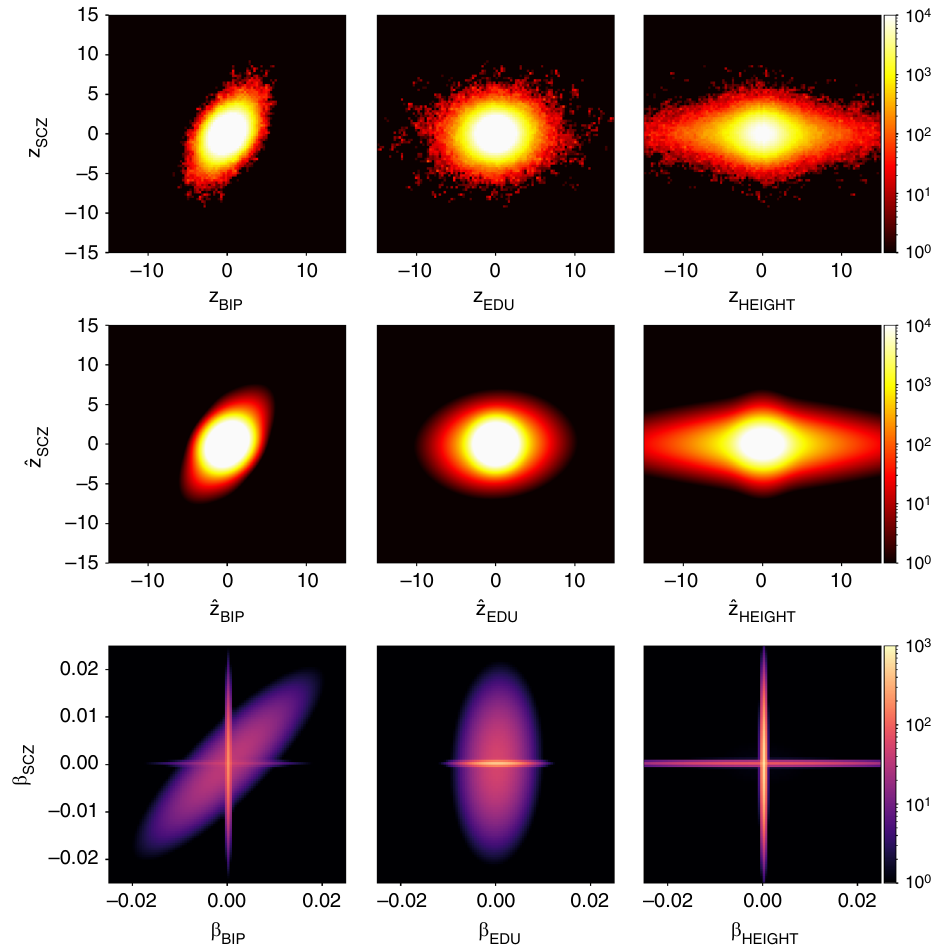
(cid:5) (cid:6) from the MiXeR